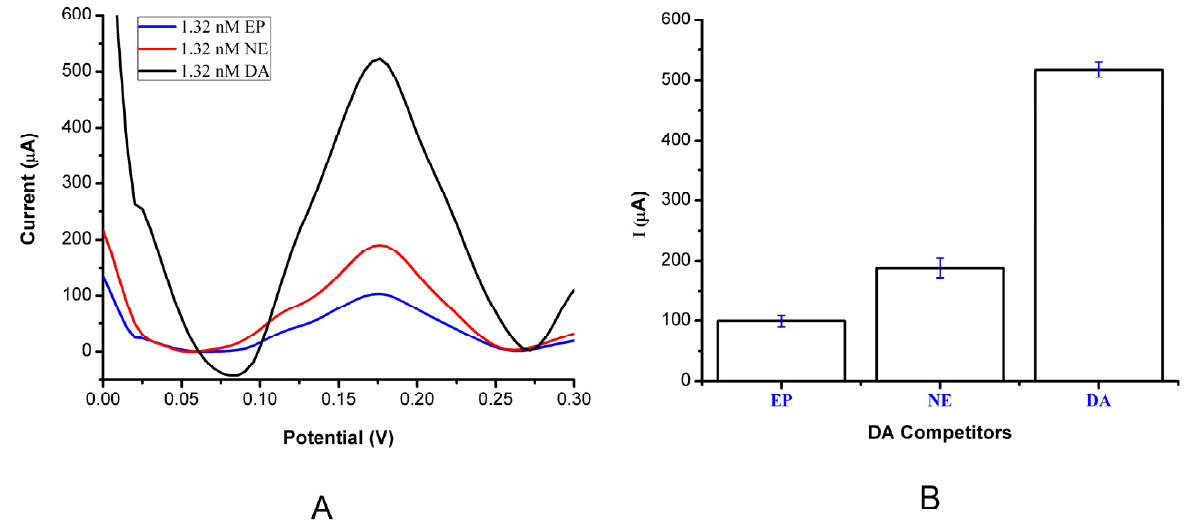
Figure 6. Selectivity study. ( A ) MIP PGE sensor response for DA (1.32 nM), NE (1.32 nM), and EP (1.32 nM) competitors; ( B ) Error bars for the MIP PGE sensor responses ( n =